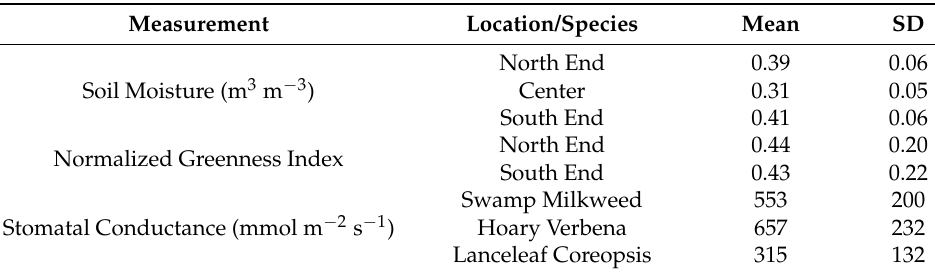
Table 2. Mean and standard deviation (SD) of ecohydrological measurements.